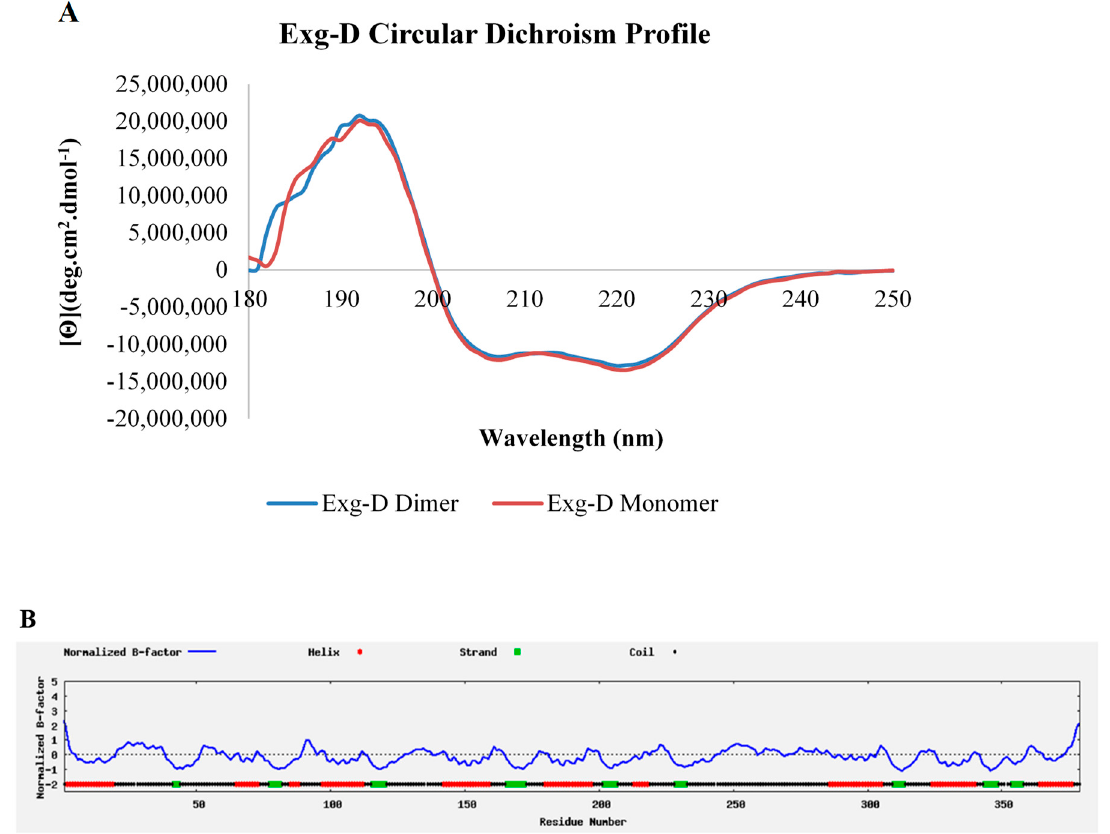
Figure 4. The secondary structure of the dimeric and monomeric forms of Exg-D. The circular dichroism profile shows that both forms of the Exg-D enzyme existed as α -helices and β -strands and coils ( A ). I-TASSER predicted that the Exg-D secondary structure consisted mostly of α -helices, β -strands and coils ( B ). Circular dichroism experiments were performed in triplicate and the values represent the means ± SD.